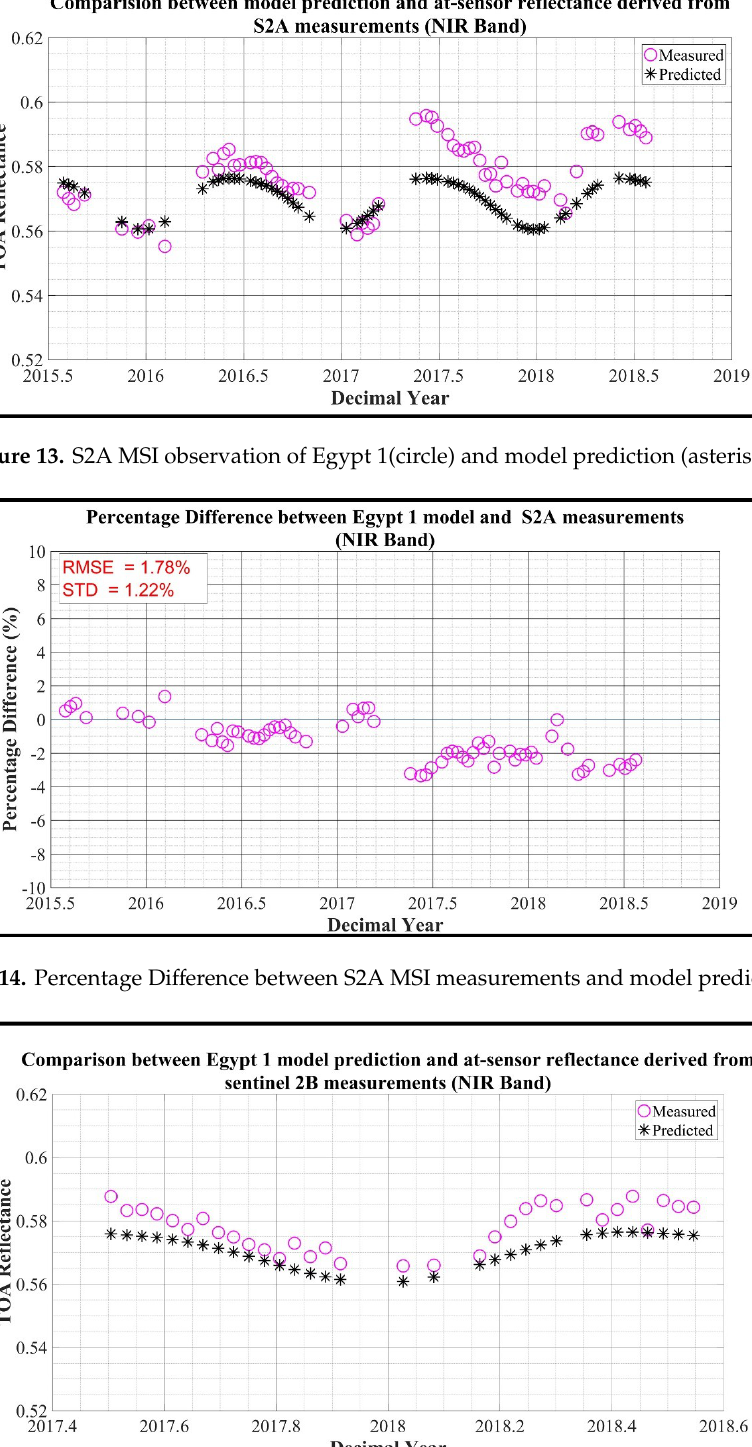
Figure 16. Percentage Difference between S2B MSI measurements and model predictions. Figures 17 and 18, respectively, show the accuracy and precision, by band, for all sensors estimated for the Egypt 1 model. With the exception of the L7 ETM+ SWIR-1 band accuracy of approximately 3.1% and the L8 OLI and S2A MSI Green band accuracies over 2.5%, all sensors demonstrate accuracy of 2.5% or better. The estimated precision of the model is within 2% for all sensor across all bands, except SWIR-2 band of L7 ETM+. In general, the precision of the model for this site is approximately 2% or better. This result shows an absolute calibration model with an accuracy of 3% is possible using Egypt 1. Figure 17. Estimate of accuracy between sensor observation and Egypt1 model prediction.